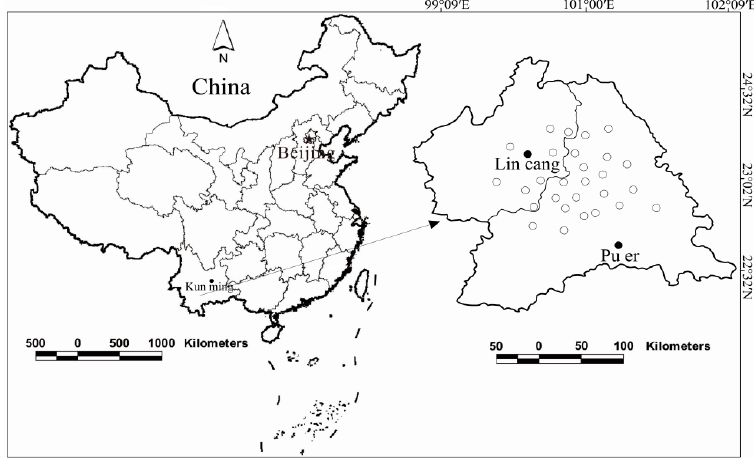
Figure 1. Location of study sites (white circles) in southern Yunnan, China.